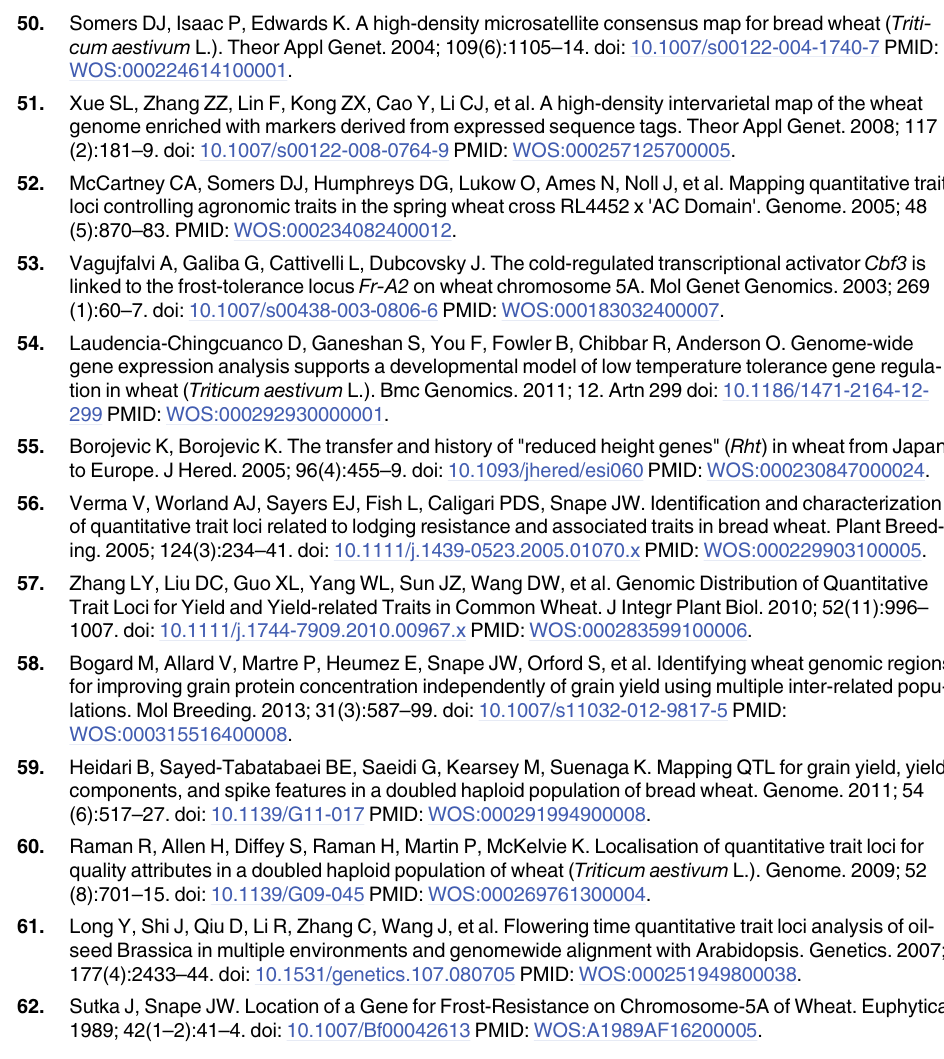
PLOS ONE | DOI:10.1371/journal.pone.0152185 March 28,